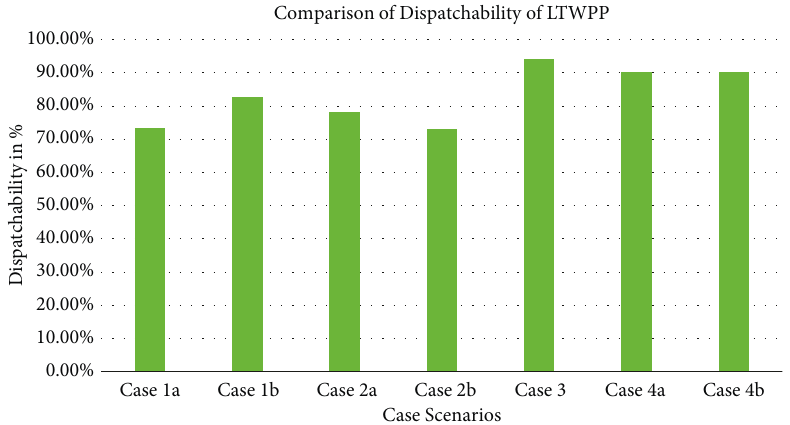
Figure 20: Comparison of dispatchability of LTWPP under different scenarios.